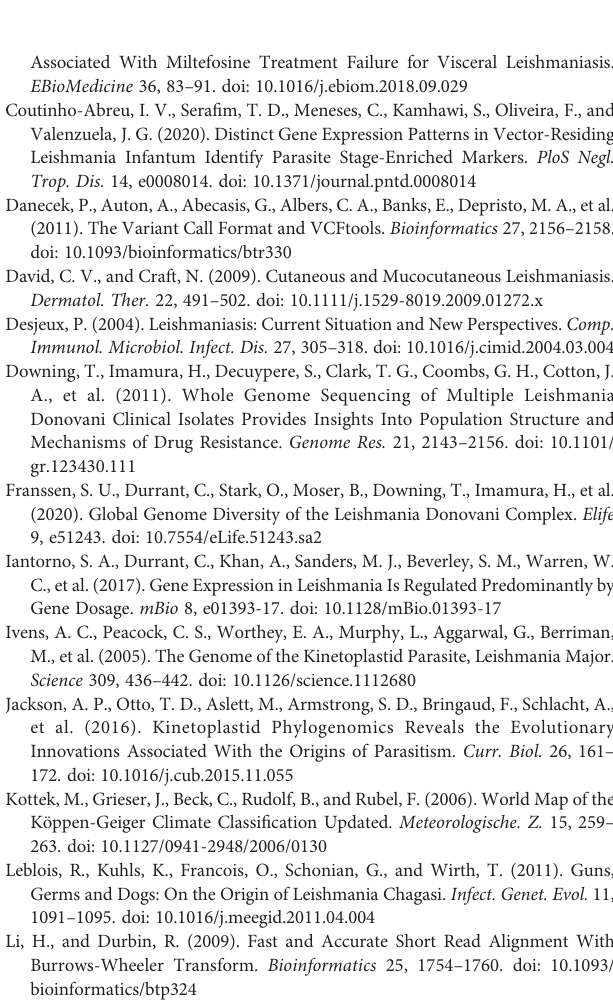
Supplementary Figure 1 | The fi gure shows the estimated seroprevalence of L. (L.) infantum in the canine population of Governador Valadares. Data corresponds to active surveillance activities conducted since 2008 up to 2014 by VL control program of Governador Valadares. Supplementary Figure 2 | Heatmap of mean monthly temperatures since 2008 to 2014 in Governador Valadares showing the presence of two clear cycles of temperature. There is a warmer period that starts in September and fi nishes in the end of April of the following year. A second colder period starts in May and fi nishes in August of the same